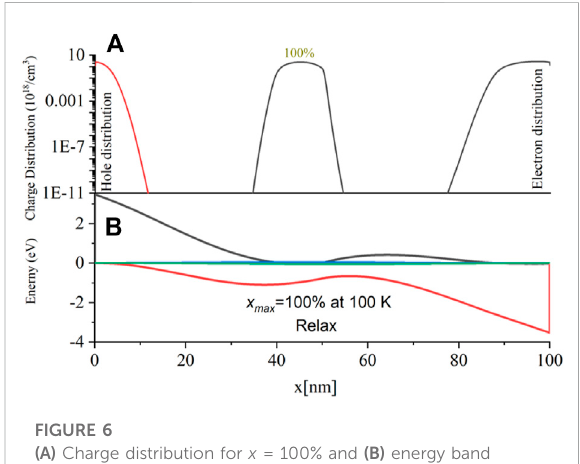
FIGURE 6 (A) Charge distribution for x = 100% and (B) energy band diagram for 100% under the relaxed condition (both at room